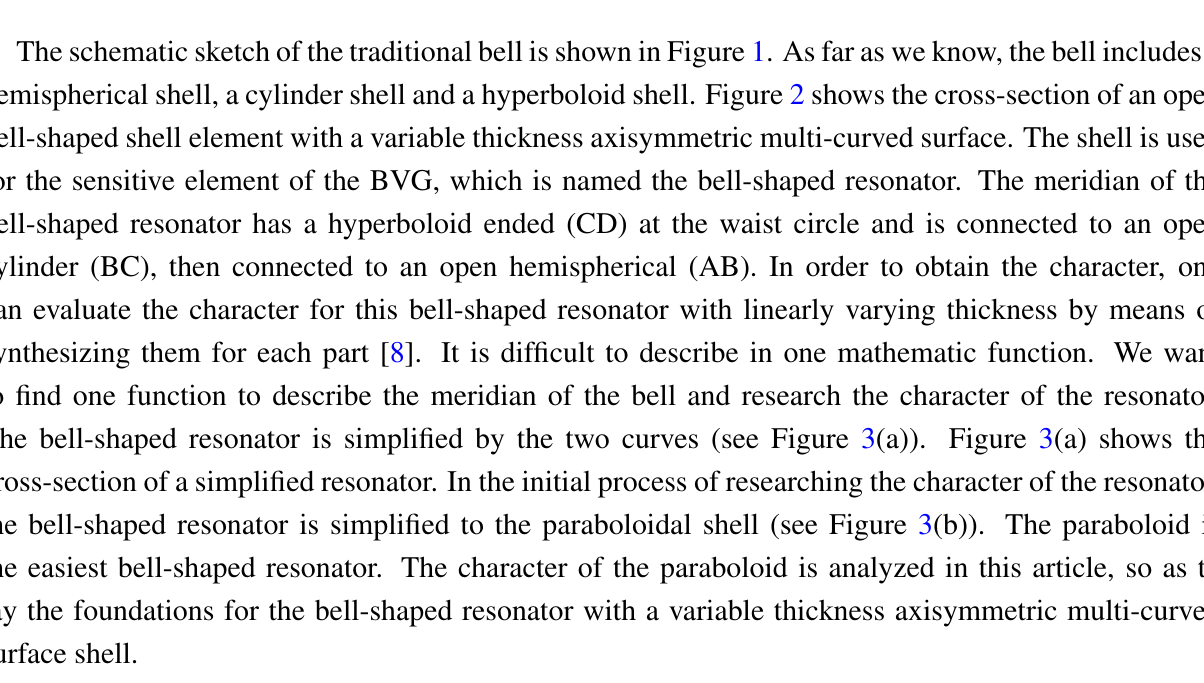
Figure 1. Traditional bell.